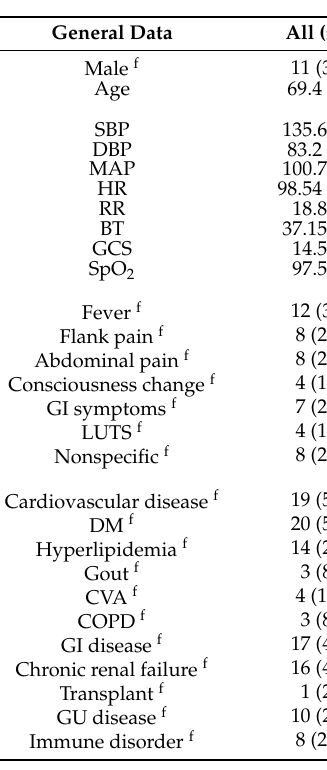
Table 1. Demographics and clinical characteristics of emphysematous